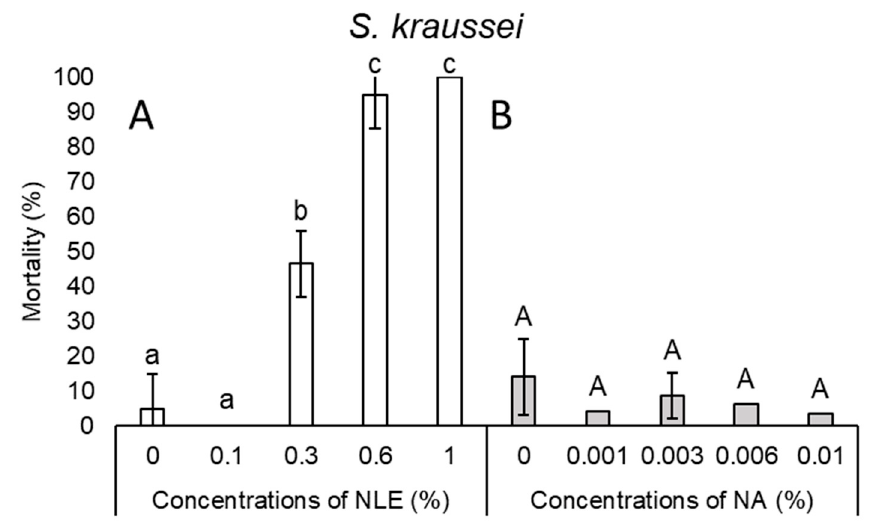
Figure 5. Mortality after 24-h exposure time of Steinernema kraussei juveniles of 0.1%, 0.3%, 0.6%, and 1% NLE ( A ) and 0.001%, 0.003%, 0.006%, and 0.01% of NA ( B ). (One-way ANOVA, Mann–Whitney U test ( A ), Tukey’s pairwise comparisons ( B ); the same letters indicate no significant difference at p < 0.05 level) .